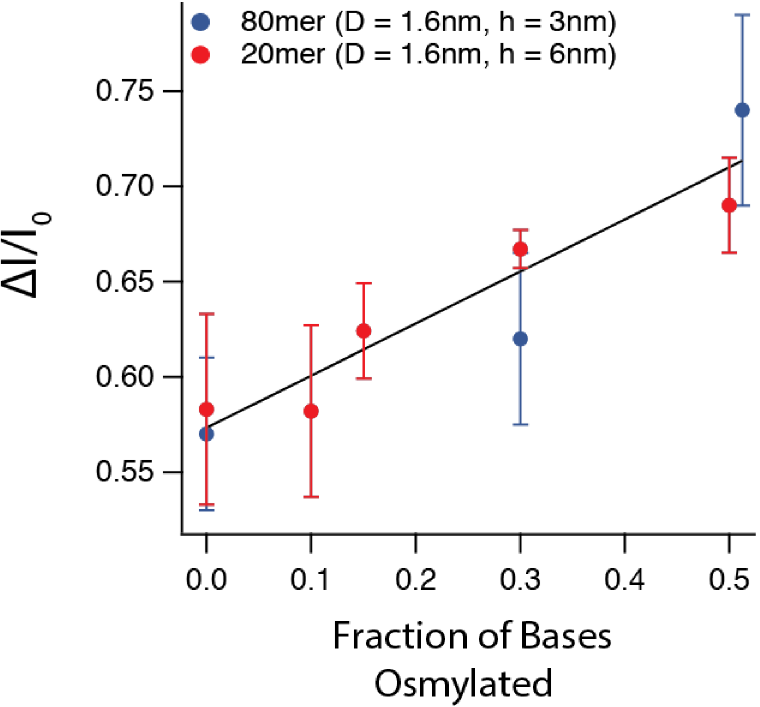
Fig 4. Ion current blockade values scale with osmylation. Fractional current blockade vs. fraction of osmylated bases. Two data sets are shown (20-mer in red and 80-mer in blue) and a linear trend line is shown to guide the eye, but does not imply any physical